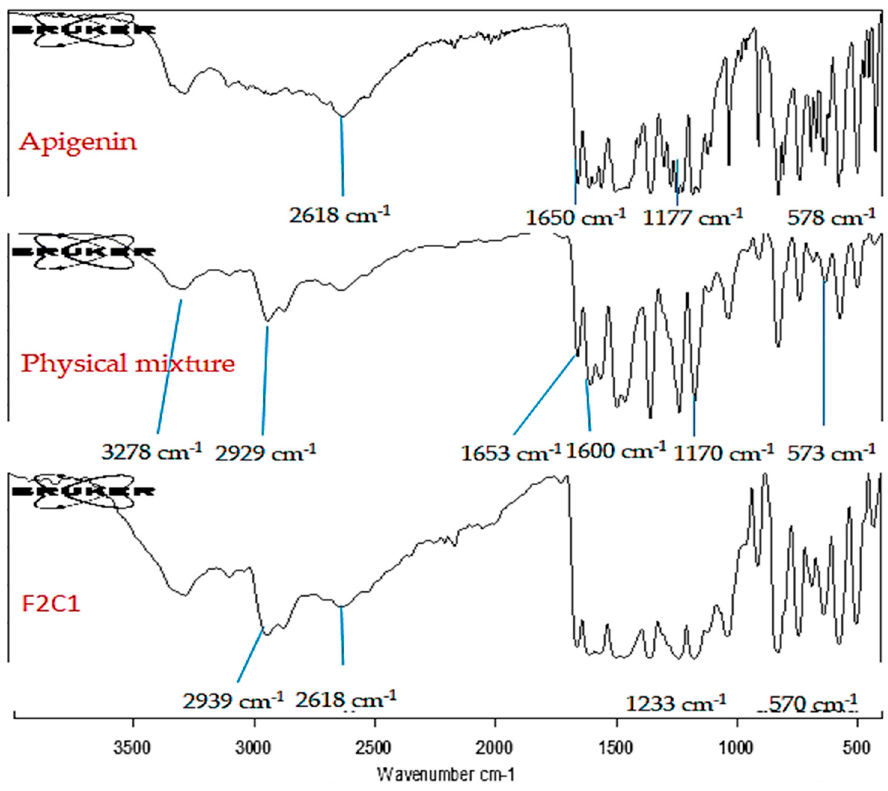
Figure 5. IR spectra of pure APG, physical mixture and chitosan-coated apigenin bilosomes